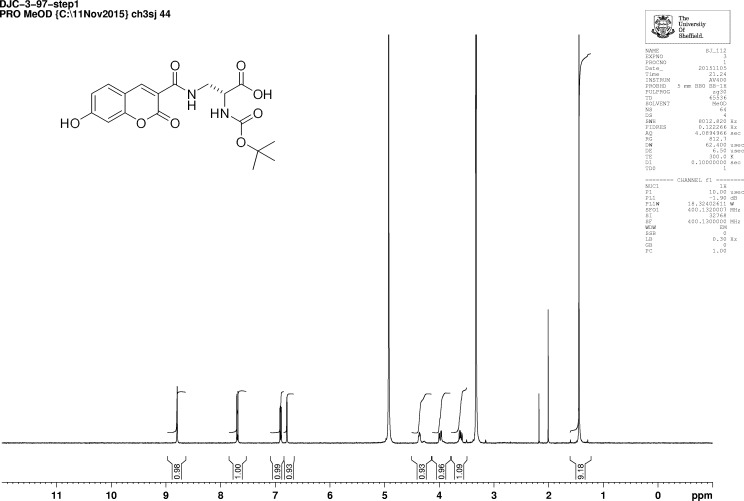
1D 1H NMR Spectrum of N-[(1,1-Dimethylethoxy)carbonyl]−3-{[(7-hydroxy-2-oxo-2H-1-benzopyran-3-yl) carbonyl] amino} D-alanine (N-Boc-HADA).